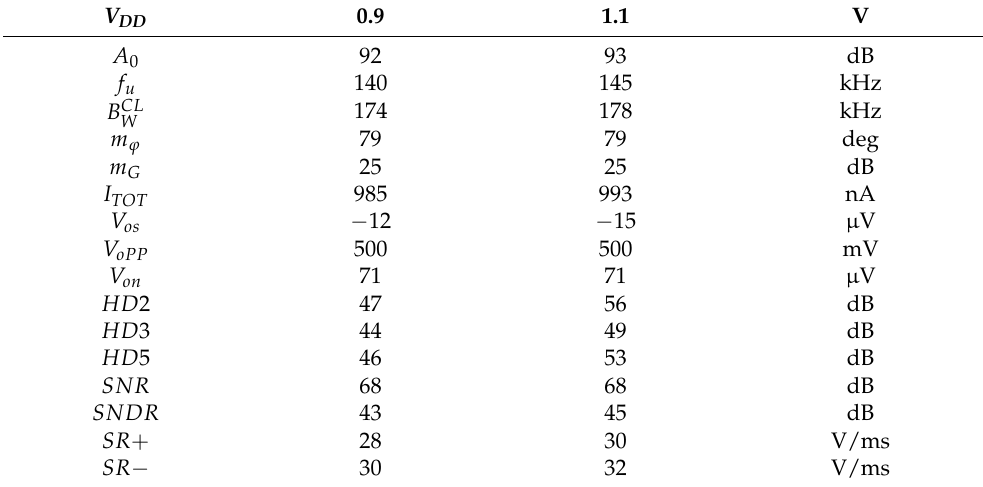
Table 4. Supply voltage variations in the 0.9 V to 1.1 V